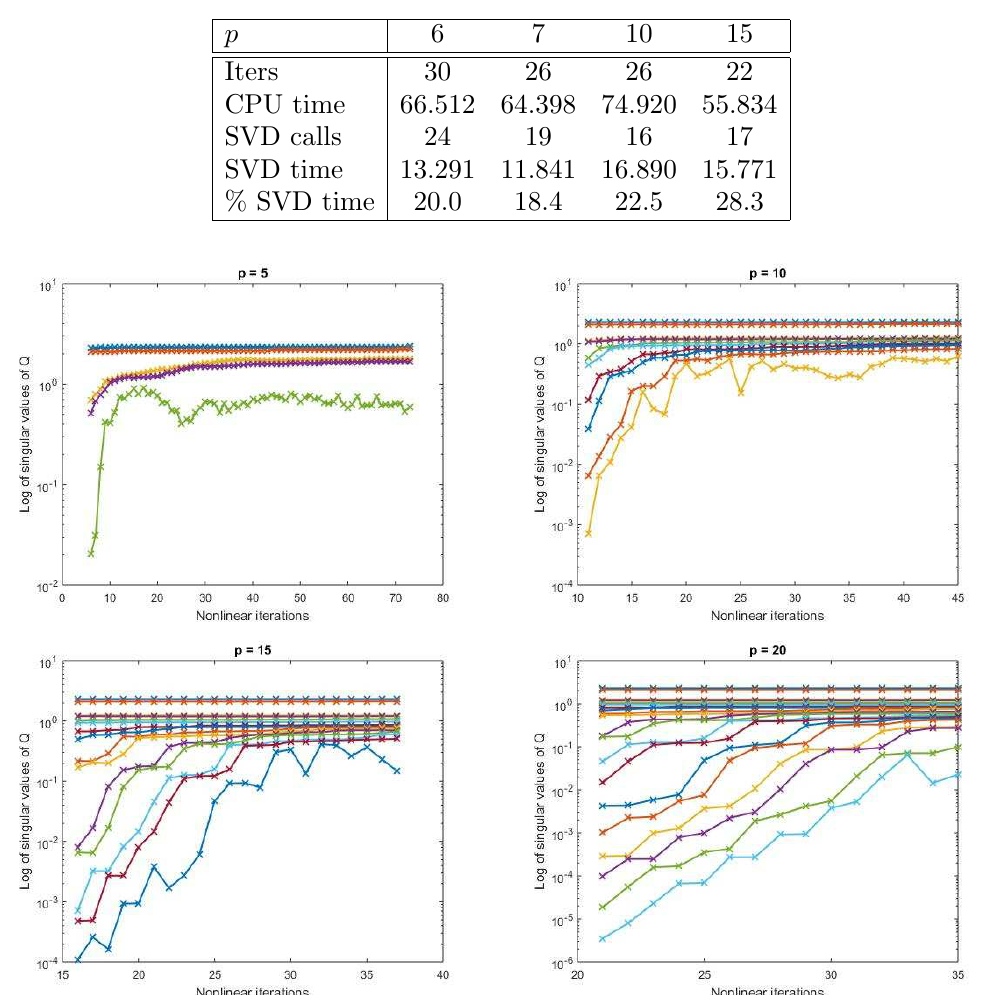
Table 6. Performance of the BRR method for Problem 3.